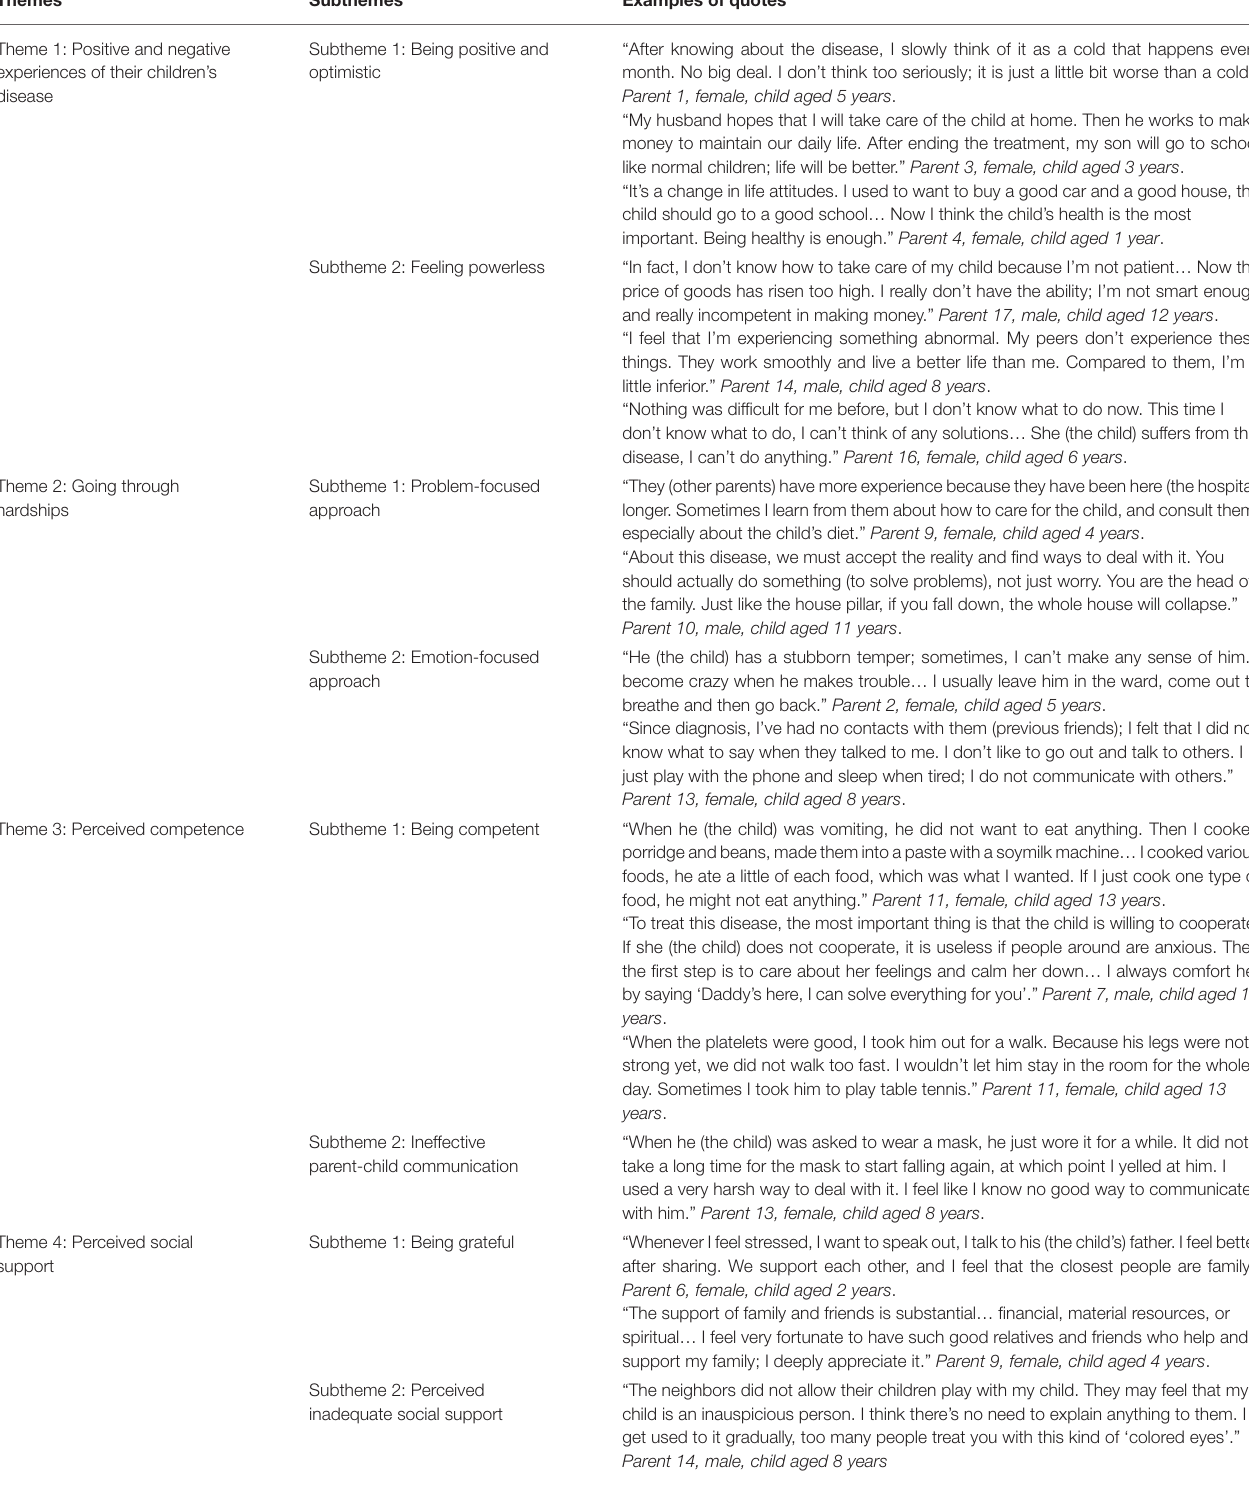
TABLE 2 | Themes, subthemes and examples of quotes from